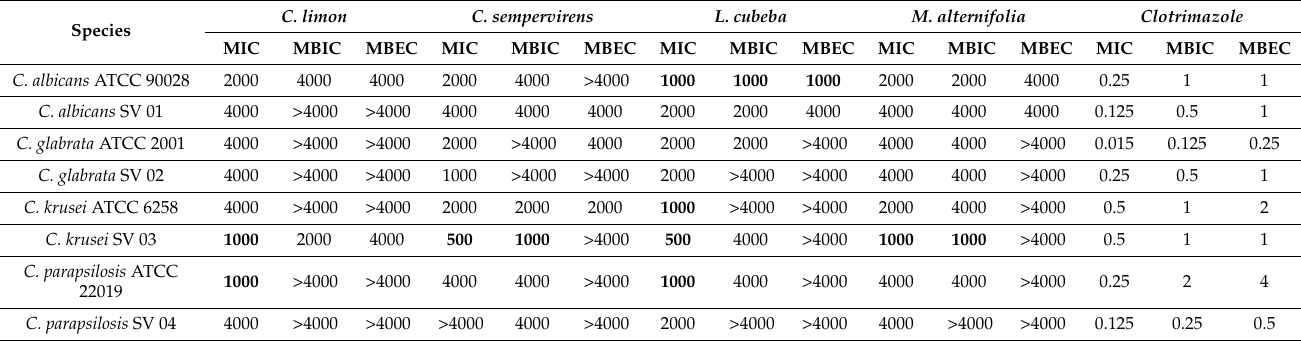
Table 3. Activity of essential oils and clotrimazole against the formation of biofilms and preformed biofilms of Candida species.